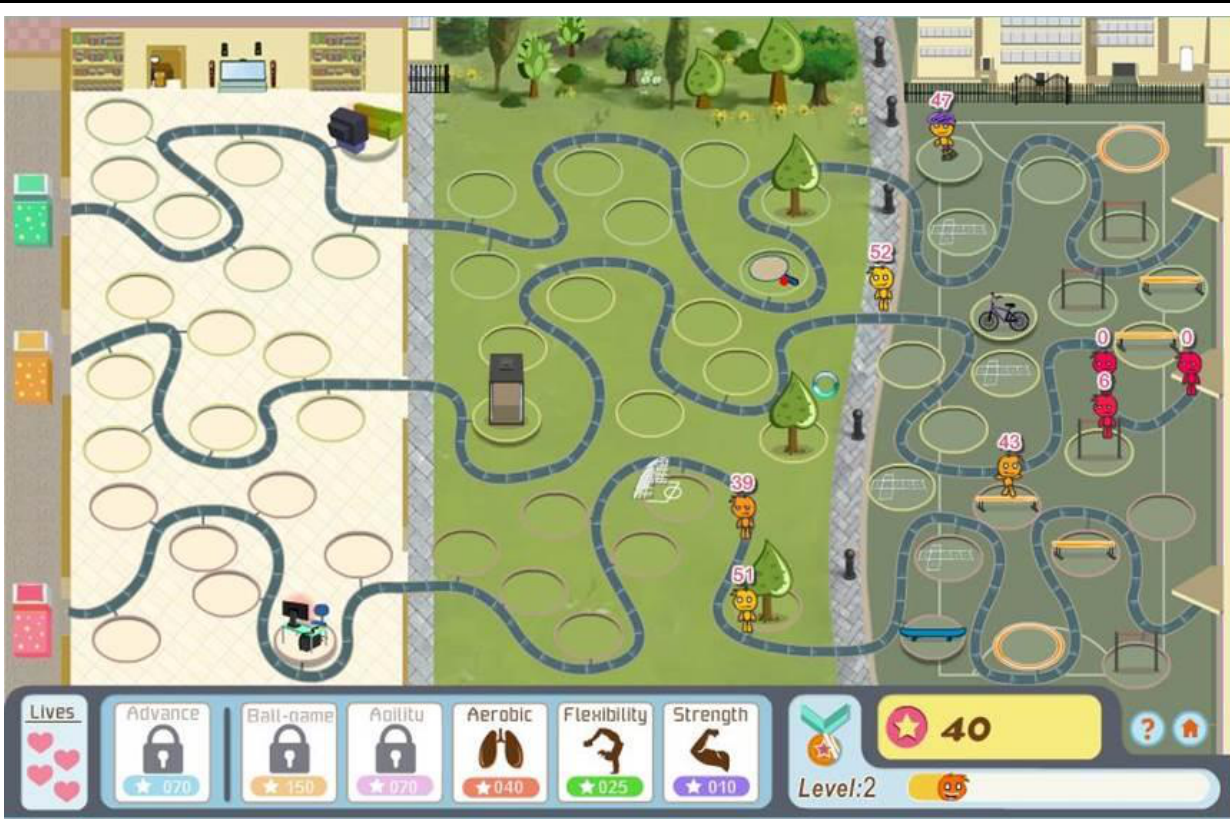
Figure 1. The main screen of the game “Couch P otatoes Defense”